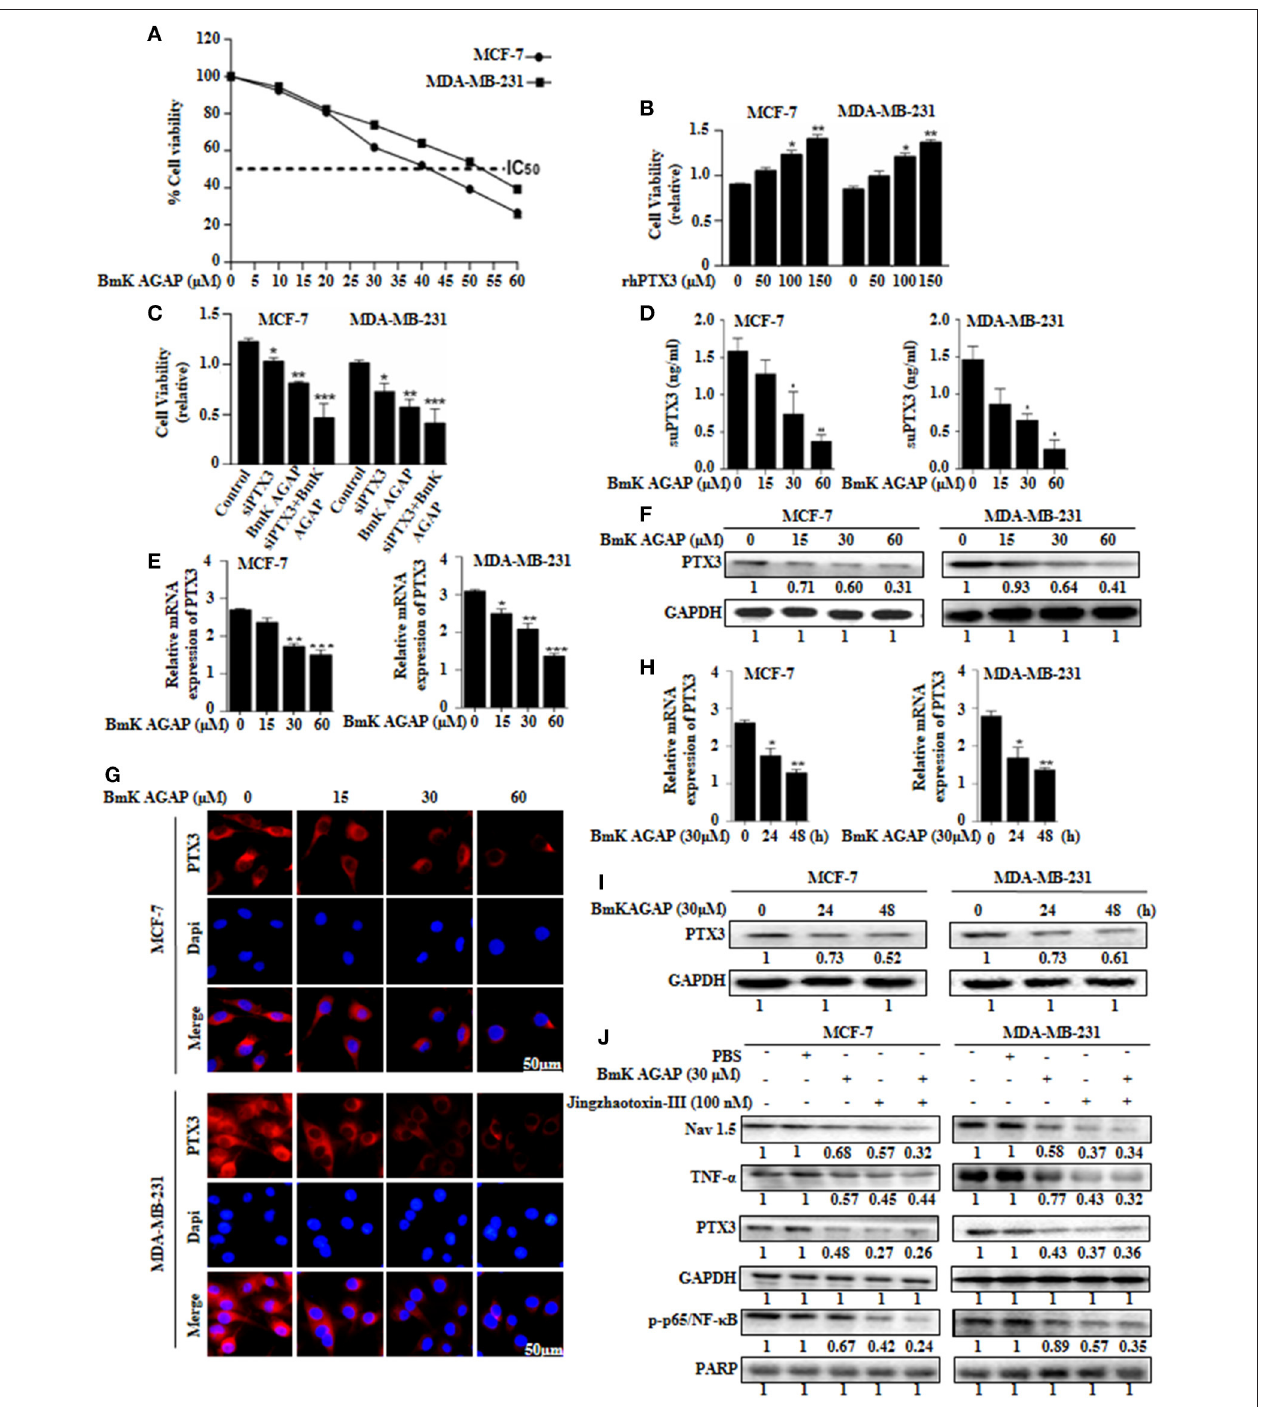
FIGURE 5 | BmK AGAP suppresses the expression of PTX3 in breast cancer cells. (A) IC50 values of rBmK AGAP for MCF-7 and MDA-MB-231 cells. The cells were treated with different concentrations of rBmKAGAP for 24h; cell viability was measured by MTT assay. (B) rhPTX3 promotes breast cancer cell survival. MCF-7 and MDA-MB-231 cells were treated with different concentration of rhPTX3 and the effect of PTX3 on cells viability examined by cell viability assay. (C) siRNA inhibition of PTX3 and/or rBmK AGAP treatment suppresses cell viability of breast cancer cells. MCF-7 and MDA-MB-231 cells were treated with rBmK AGAP or siPTX3 or both, and their effect on cell viability was examined by MTT assay. (D) rBmK AGAP suppresses PTX3 secretion. MCF-7 and MDA-MB-231 cells were treated with different concentrations of rBmK AGAP for 48h. SecretedPTX3 in supernatant samples were measured using ELISA. (E) Relative gene expression of PTX3 following rBmK AGAP treatment. Cells were treated with different concentrations of rBmK AGAP for 48h, and the expression of PTX3 and GAPDH (internal control) were